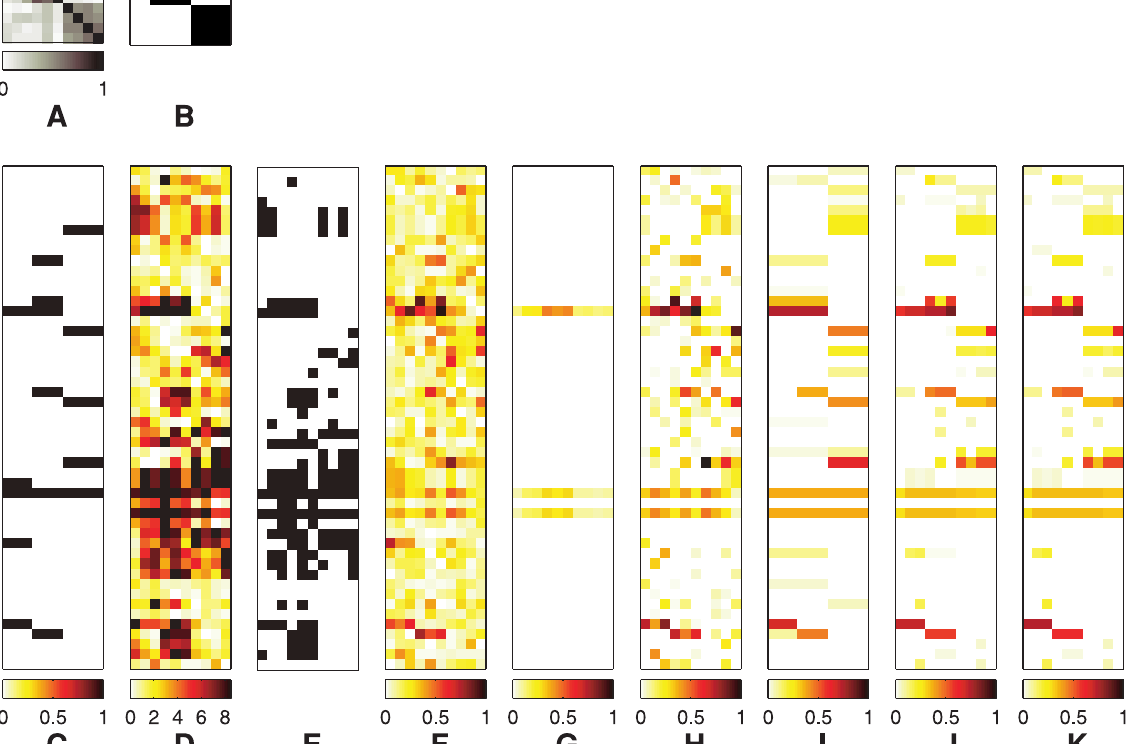
Figure 4. Results of association analysis by different methods based on a single simulated dataset. Association strength 0.8 and threshold r ~ 0 : 3 for the QTN were used. (A) The 10 | 10 correlation coefficient matrix of traits. It contains three blocks of correlated traits of sizes 3, 3, and 4, respectively. (B) The correlation coefficient matrix in (A) thresholded at r ~ 0 : 3 . The black pixels in the lower triangular part of the matrix indicate edges included in GFlasso. (C) The true regression coefficients and sparsity pattern used in simulation. (D) { log p - value ð Þ , where p - values were obtained from single-SNP permutation tests performed for each phenotype separately. (E) Black pixels indicate SNP-trait pairs with significant association at a ~ 0 : 01 based on the results of p - values in (D). Values of the estimated regression coefficients are shown for (F) ridge regression, (G) PCA-based regression, (H) lasso, (I) G c Flasso , (J) G 1 Flasso , and (K) G 2 Flasso . In Panels (C)–(K), rows correspond to SNPs, and columns to w w phenotypes. Columns for traits in (C)–(K) are aligned with the columns in (A) and (B).